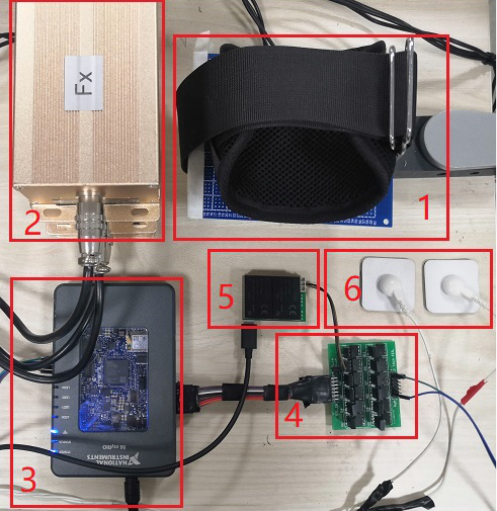
Figure 7. Hardware platform of the proposed force tracking control system. (Module 1 is used to fix wrist; module 2 is a force sensor transmitter; module 3 is a NI MyRIO 1900; module 4 is a multi–channel electrical stimulator; module 5 supplies power; module 6 is a pair of electrodes.)